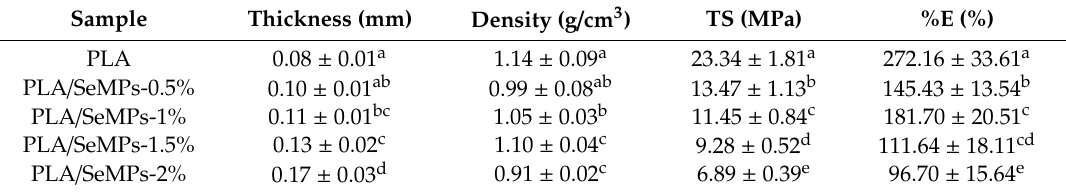
Table 2. Physical properties and mechanical properties of PLA and PLA / SeMP composite membranes. Sample Thickness